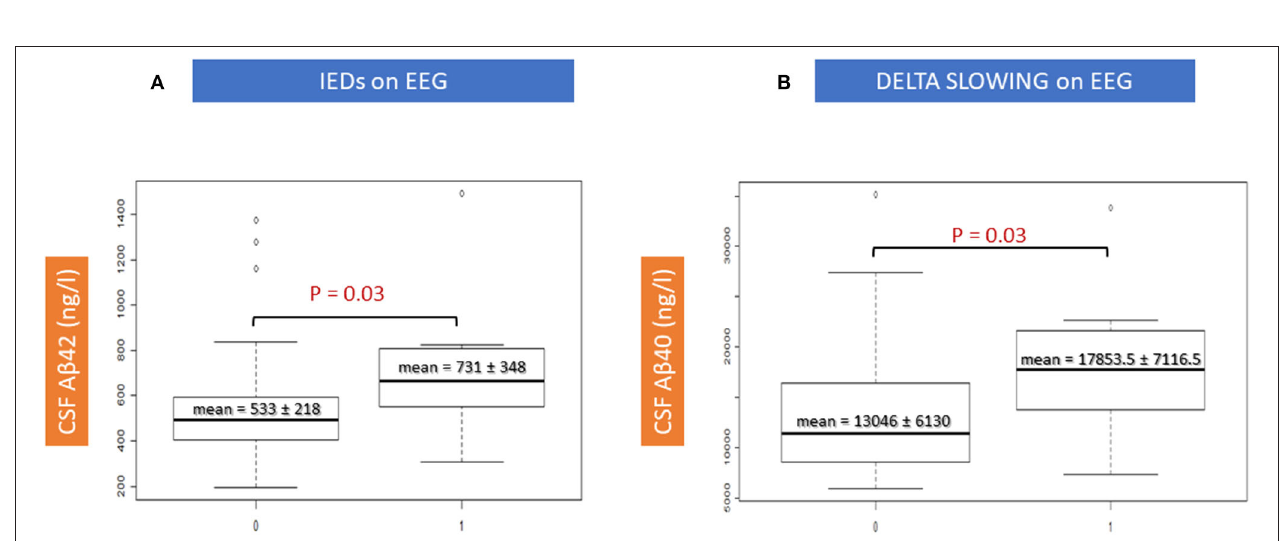
FIGURE 4 | Correlations between EEG features and CSF amyloid peptides. IEDs, interictal epileptiform discharges.